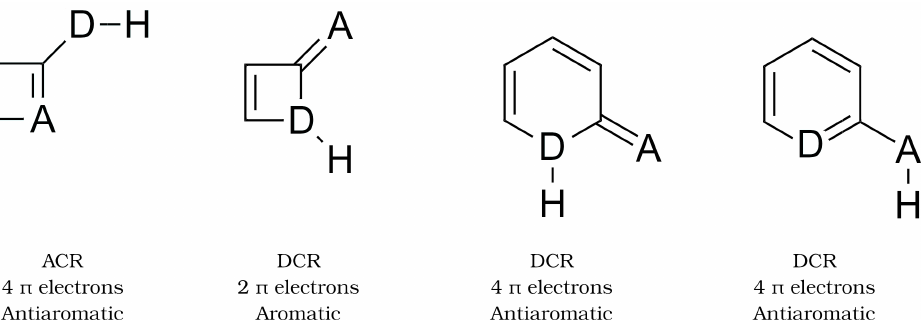
Figure 5. Aromatic and antiaromatic character of the monomers shown in Figure 2 determined with Hückel